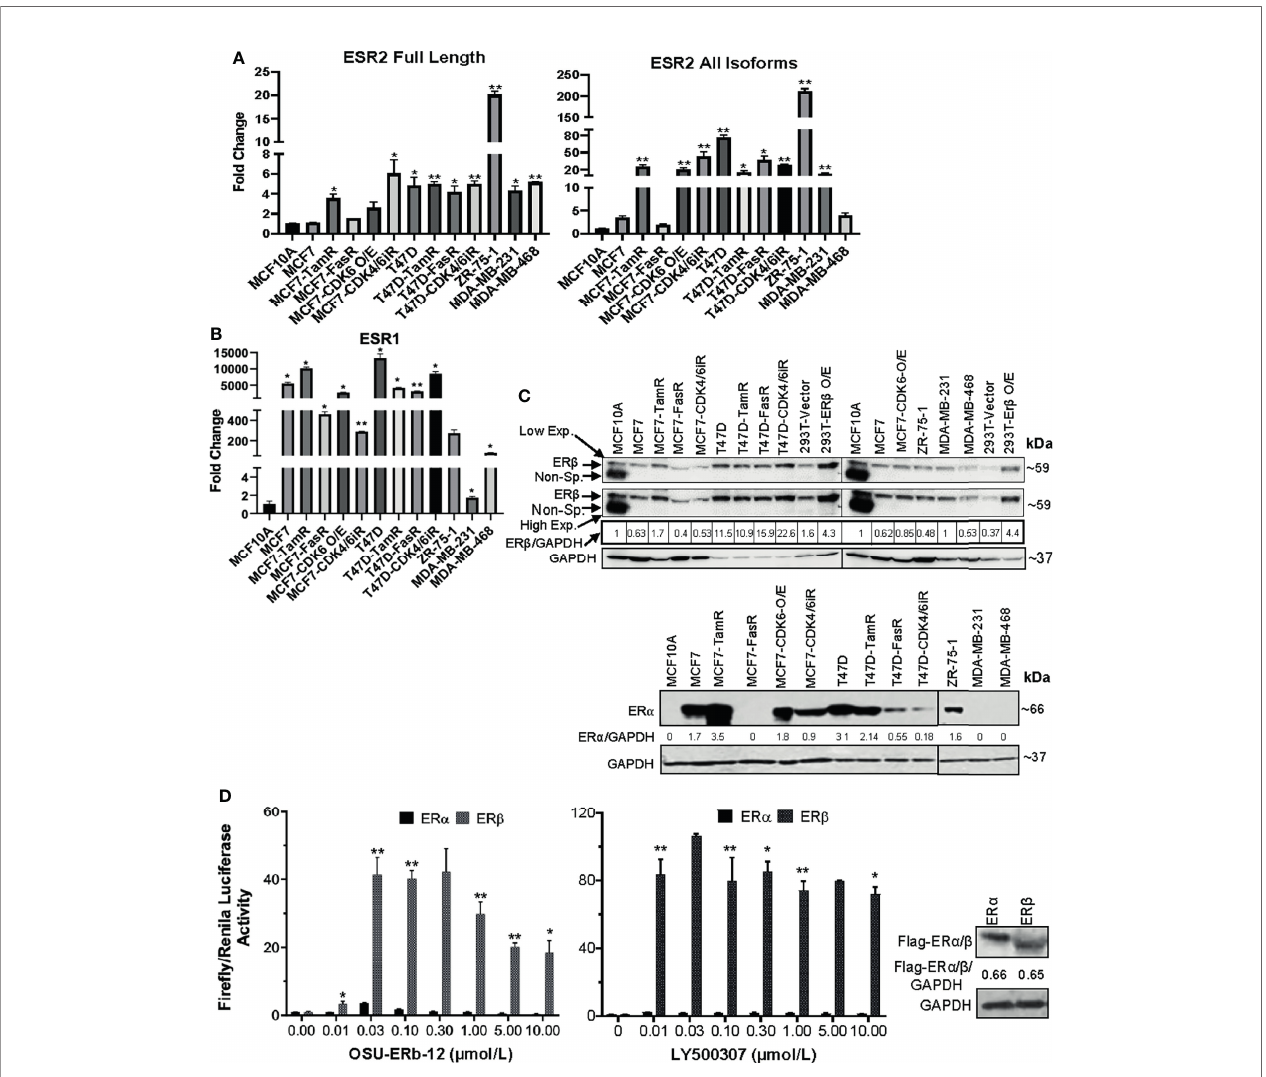
FIGURE 1 | (A – C) ESR1 and ESR2 genes are differentially expressed in ER a + parental, respective endocrine-resistant, and triple-negative breast cancer cell lines. (A, B) Expression of ESR1 and ESR2 in immortalized mammary MCF10A, transformed ER a + MCF7 and T47D, endocrine-resistant MCF7-TamR, MCF7-FasR, T47D-TamR, and T47D-FasR, CDK6 overexpressing MCF7 (MCF7-CDK6 O/E), CDK4/6 inhibitor-resistant MCF7 (MCF7-CDK4/6iR) and T47D (T47D-CDK4/6iR), ZR-75-1, and triple-negative breast cancer (TNBC; MDA-MB231, MDA-MB-468, Hs578t) cell lines. Total RNA was isolated from the established cell lines using TRIzol. The expression of each gene was assessed by quantitative RT-PCR (qRT-PCR) performed with the DNase-treated RNA samples using gene-speci fi c primers spanning exon – exon junctions that include large introns in the corresponding genomic sequence to avoid genomic DNA ampli fi cation. Gene expression was calculated by the DD Ct method using GAPDH as an internal control. The expression of each gene is shown as the fold change relative to MCF10A. All reactions were done in triplicate, and the experiment was repeated twice. Data were plotted as mean ± SD. (A) ESR2 genes; full length (left) and all isoforms (right). (B) ESR1. (C) Whole-cell lysates were extracted, and immunoblot analyses were performed for ER b and GAPDH (loading control) (upper panel), and ER a and GAPDH (lower panel). The intensity of the protein bands was quanti fi ed using Image Studio (LiCor) software. Numbers under the lanes of each cell line represent normalized values of the corresponding protein band (ER b or ER a ). The normalized band intensity of MCF10A was considered as 1. Immunoblot analyses were repeated twice with corresponding biological replicates. Reproducible results were obtained in each independent experiment. GAPDH, glyceraldehyde-3-phosphate dehydrogenase. For ER b (upper panel), two different exposures were provided; low exp.= low exposure; high exp.= higher exposure of the blot. (D) ERE-luciferase-driven promoter activity upon treatment with selective ER b agonists is signi fi cantly higher in ectopically expressing cells with ER b compared to that of ER a . HEK293T cells were transfected with c-Flag pcDNA3 (vector control), c-Flag ER a or c-Flag ER b in combination with ERE-Luciferase (reporter) and TK-Renilla (pRLTK; internal control) plasmids (as described in Materials and Methods ). Forty-eight hours after treatment of the cells with ER b -speci fi c agonists Renilla and Fire fl y, luciferase activities were measured using the dual-luciferase reporter assay system. Fire fl y luciferase was normalized to Renilla Luciferase. Treatment with: OSU-ERb-12 (0 – 10 µmol/l) (left) and LY500307 (0 – 10 µmol/l) (middle). Each assay was performed in triplicate with three experimental replicates (mean ± SD, *p < 0.05, **p < 0.01). The right panel shows equal expressions of ER a and ER b as determined by Western blot analysis using the anti- fl ag antibody. Intensity of Flag-ER a /ER b was normalized to GAPDH. The numbers under the corresponding protein band represent normalized values of the corresponding protein band